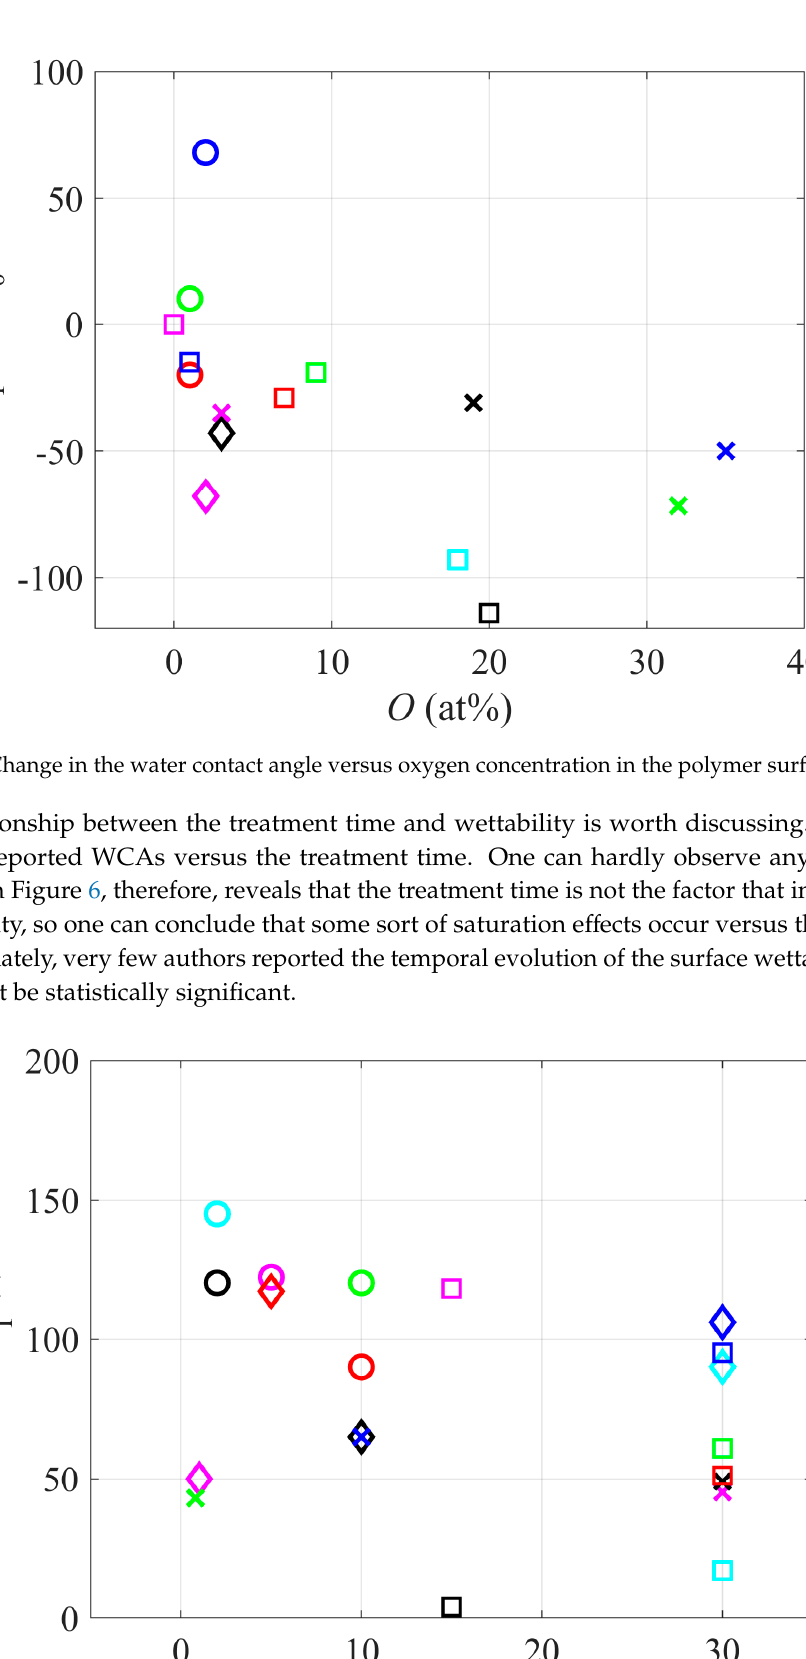
Figure 4. Water contact angle versus the concentration of oxygen in the polymer surface film.